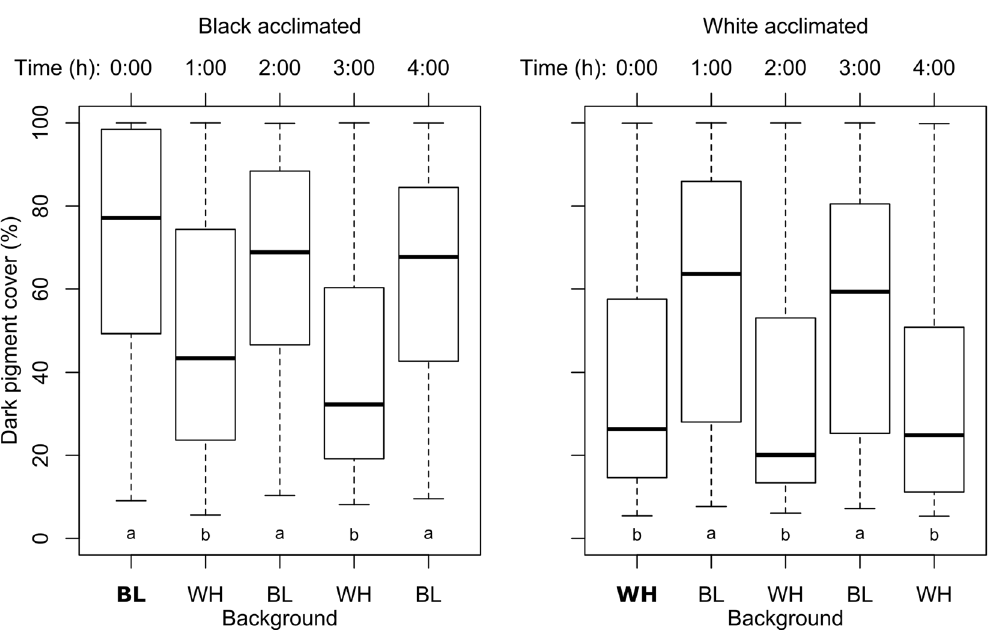
Figure 4. Box-and-whisker plots of dark pigment cover (%) during repeated shifts of Crangon crangon (N = 33) between black (BL) and white (WH) backgrounds. First measurement (in bold) was performed after 24 h acclimation and all subsequent measurements after 1 hour permanence on the respective background. Time: number of hours after acclimation. Different letters indicate groups that are significantly different (P < 0.01) based on Dunn-Bonferroni corrected post-hoc